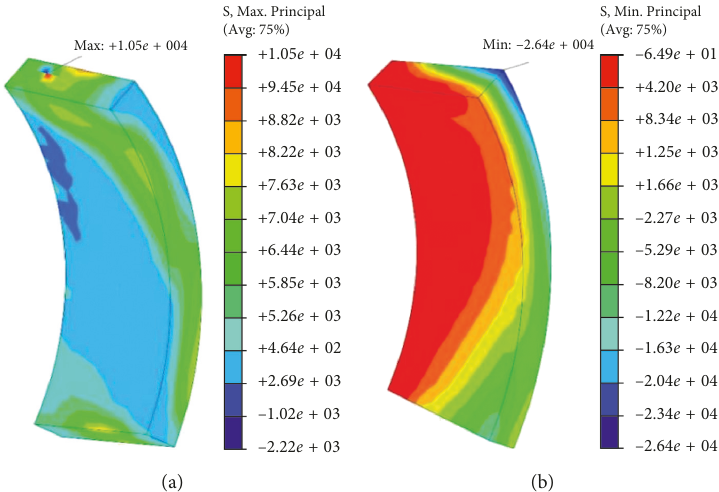
Figure 12: Maximum stress nephogram of the segment. (a) Tensile stress nephogram. (b) Compressive stress nephogram.